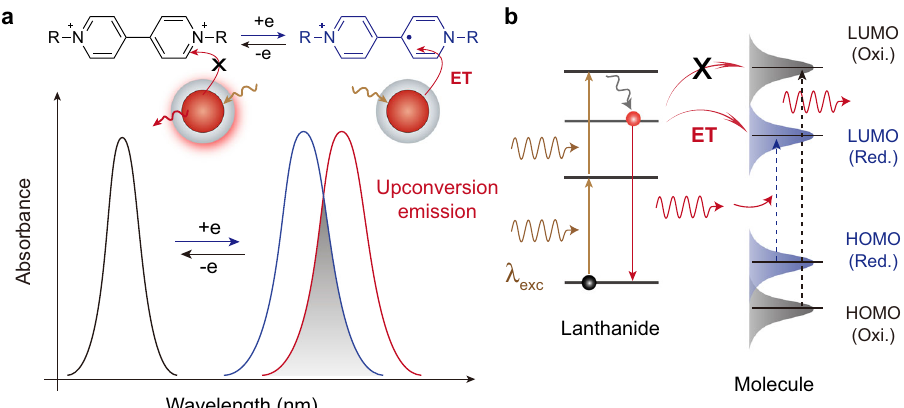
Fig. 1 Molecular-assisted surface electrochemical tuning (MASET). a Schematic illustration of electrochemically controlled energy transfer (ET) from UCNPs to viologen molecules (R represents a functional group). An applied electric fi eld induces electrochemical conversion of viologen molecules. For a given set of nanocrystals and viologen molecules, no energy transfer occurs upon NIR laser excitation ( λ exc ), owing to lack of spectral overlap between nanocrystal emission and dye absorption. Applying an external electric fi eld drives the oxidised state (Oxi.) of viologen molecules to the reduced state (red.) through a redox process, resulting in selective quenching of luminescence owing to spectral resonance between nanocrystals and molecules. A reverse electric fi eld oxidises the reduced viologen molecules, leading to a recovery of upconversion emission. b Simpli fi ed energy level scheme of lanthanide-activated UCNPs and schematic energy level diagram of viologen molecules in oxidised (Black) and reduced (Blue) forms, illustrating electrically controlled energy transfer from UCNPs to dye molecules. Solid and dashed lines represent electronic transitions.